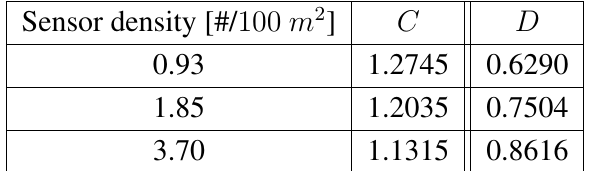
Table 7. Estimated factors by nonlinear regression.